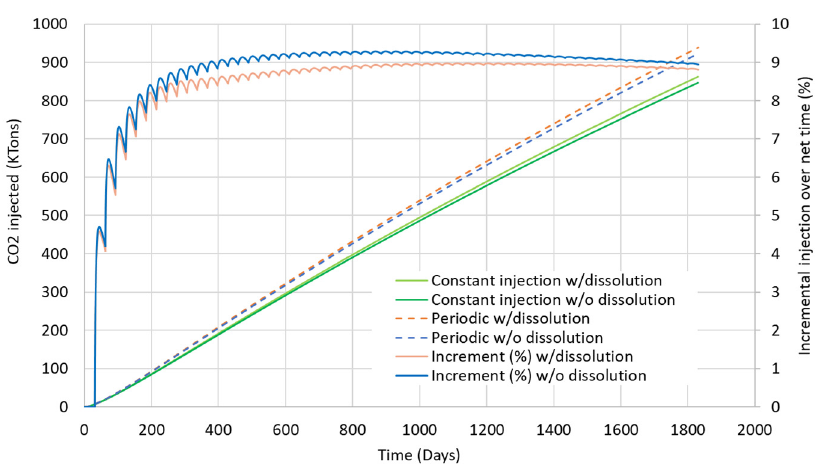
Figure 22. Effect of CO 2 dissolution in water. As seen the effect is insignificant in this case and context.